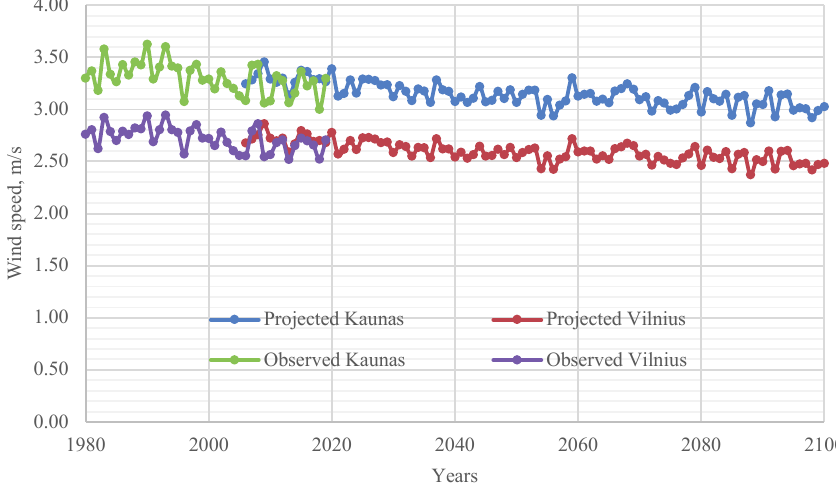
Fig . 5. Wind speed change over the century in Vilnius and